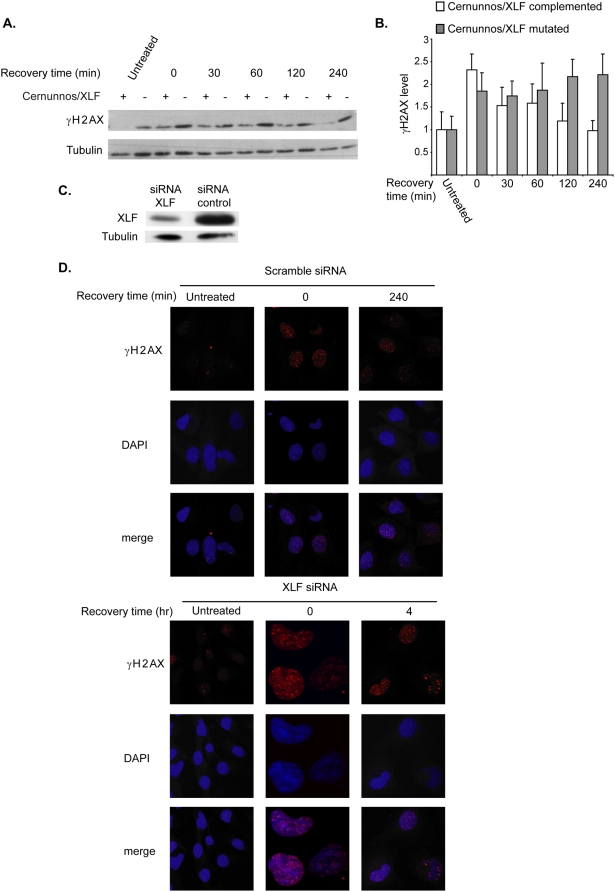
Cernunnos/XLF mutated or downregulated cells exhibit impaired repair of DSBs following treatment with low aphidicolin concentrations.A. Cernunnos/XLF mutated and complemented cells were treated with 0.5 µM aphidicolin for 24 hours and were then transferred to regular growth media for 0–240 minutes. Protein Extracts were prepared at the indicated times after transfer to regular media and analyzed by immunoblotting with anti- γH2AX antibodies (α-γH2AX). Untreated cells were analyzed as control. B. Quantification of γH2AX levels in Cernunnos/XLF mutated and complemented cells following 0.5 µM aphidicolin treatment for 24 hours and different recovery times. γH2AX level was normalized to tubulin control and to untreated cells. Bars represent mean and standard error of three independent experiments C. Western blot probed with anti- Cernunnos/XLF antibody in BJ cells transfected with siRNA against Cernunnos/XLF. Transfection with a nonspecic siRNA was analyed as a control. Equal loading was confirmed by probing with an anti-Tubulin antibody. D. BJ cells transfected with siRNA against Cernunnos/XLF or non-specific control siRNA following 0.5 µM aphidicolin treatment for 24 hours and at a recovery time of 240 minutes. Cells were fixed and stained with anti γH2AX antibody.